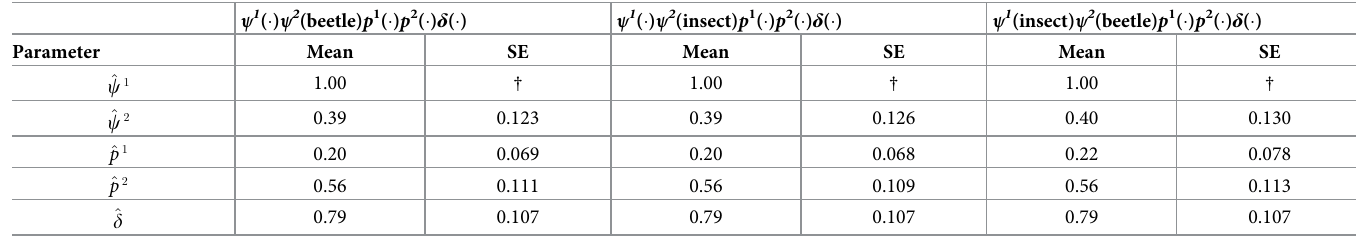
Table 2. Parameter estimates for top ranked models of the acoustic–activity set. Estimates for ψ 2 (the probability that state 2 –high activity or feeding–actually occurred given bat presence) were obtained by averaging site-specific predicted values and their standard errors. Parameter definitions are provided in the footnote to Table 1. ψ 1 ( � ) ψ 2 (beetle) p 1 ( � ) p 2 ( � ) δ ( �